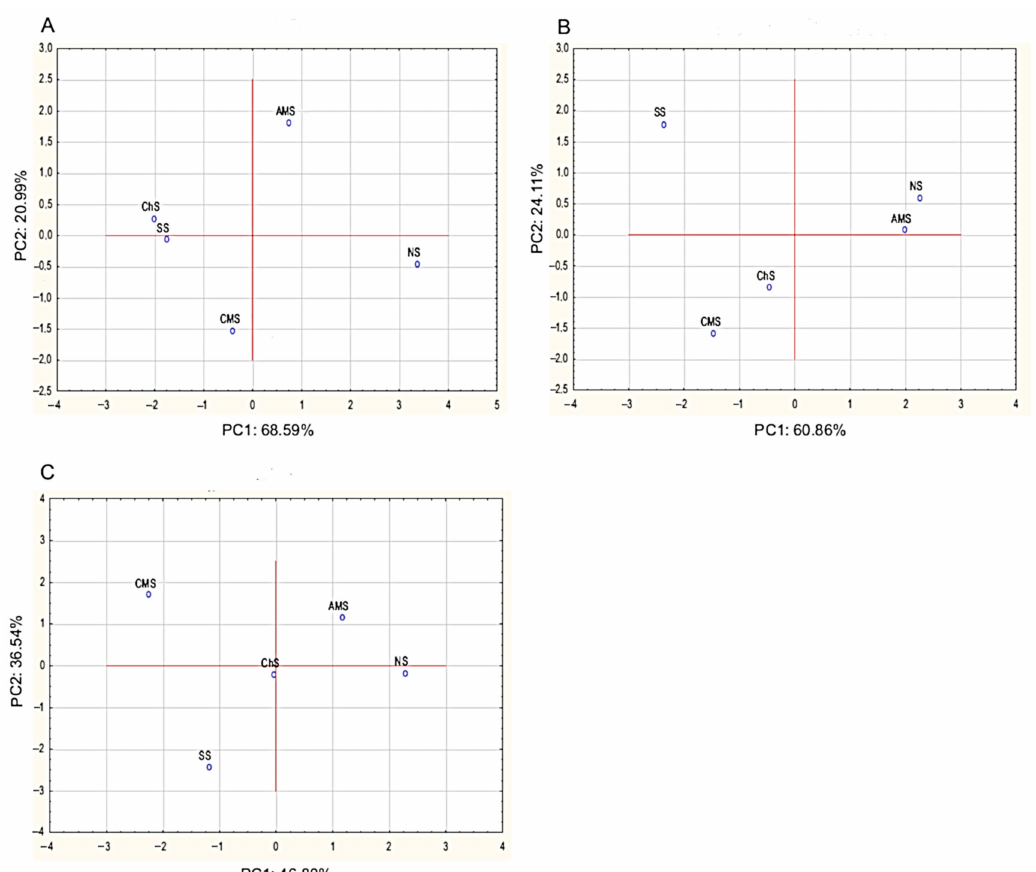
Figure 1. Principal Component Analysis (PCA) showing the effects of Aronia melanocarpa, Chaenomeles superba, and Cornus mas leaf extracts on the microbial quality of pork sausages during 29 days of refrigerated storage in MAP. AMS—sausage with Aronia melanocarpa leaf extract (5% v / w ); ChS—sausage with Chaenomeles superba leaf extract (5% v / w ); CMS—sausage with Cornus mas leaf extract (5% v / w ); NS—sausage with curing salt containing sodium nitrate (III); SS—control sausage with salt and spices only (without extract and nitrates (III)); ( A )—total psychrotrophic count (TPC); ( B )— Enterobacteriaceae ; ( C )—lactic acid bacteria